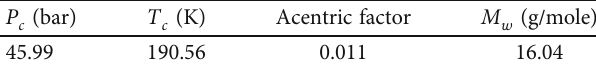
Table 1: Physical properties of